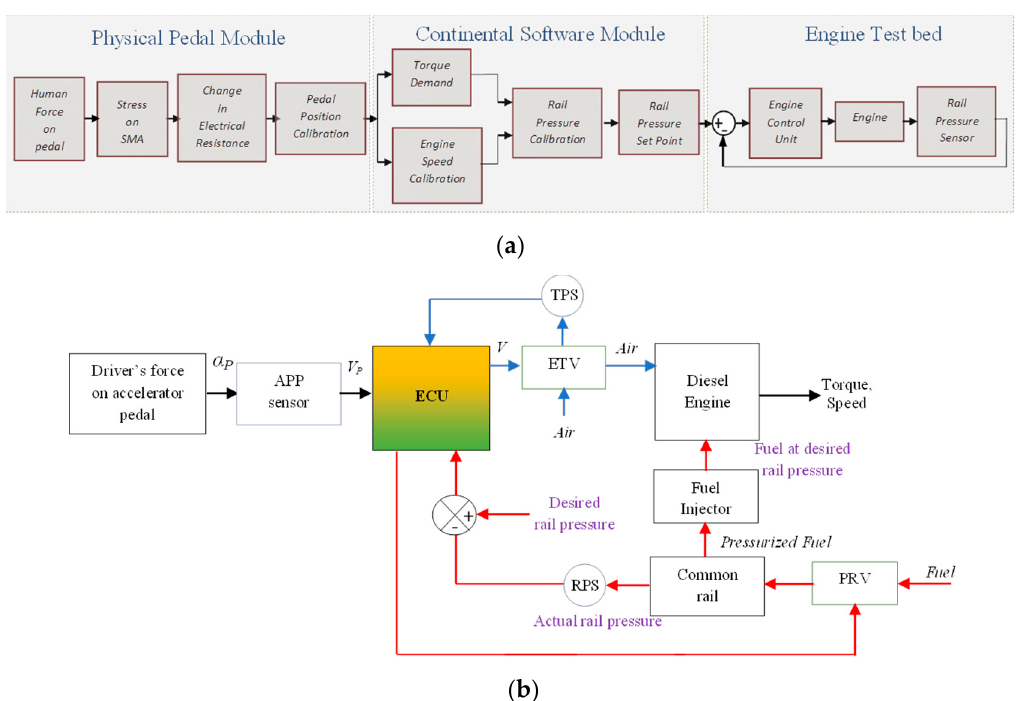
Figure 11. Test control block-diagram; ( a ) testbed at Continental Automotive Components (India) Pvt. Ltd., ( b ) flow diagram of rail pressure regulation on common rail diesel system.